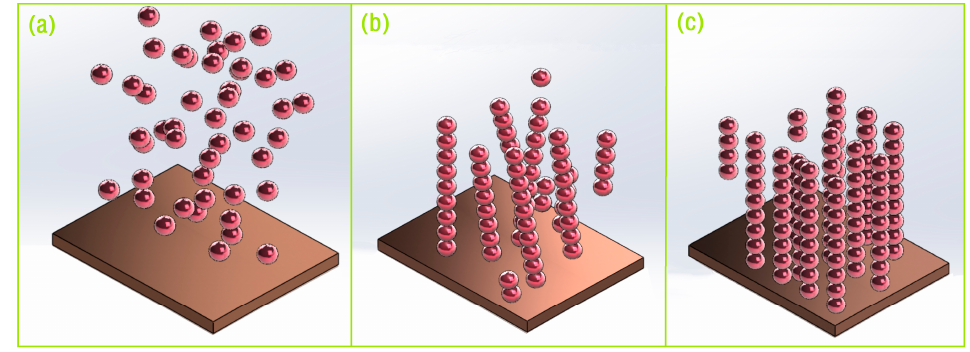
Figure 7. The schematic view of the formation of MR fluid microstructure: ( a ) under zero magnetic field. ( b ) under an applied middle magnetic field. ( c ) under an applied high magnetic field.